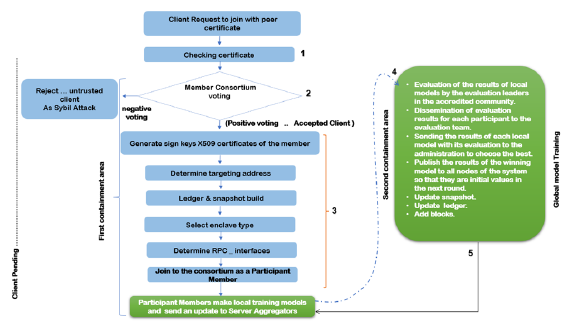
Fig. 4. Proposed F.L. framework